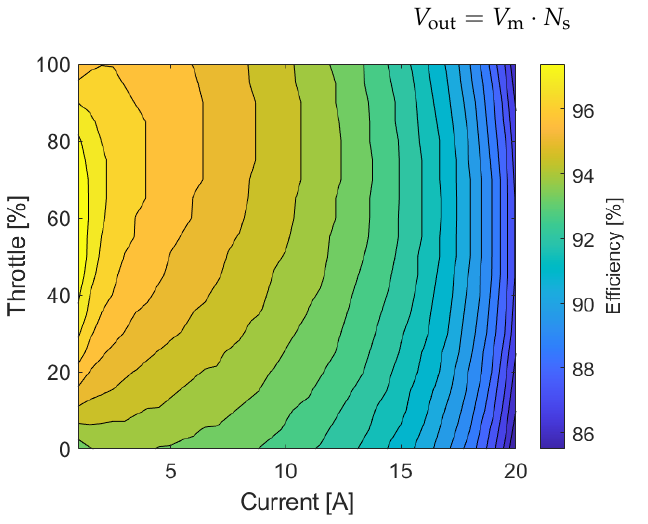
Figure 4. Motor controller efficiency